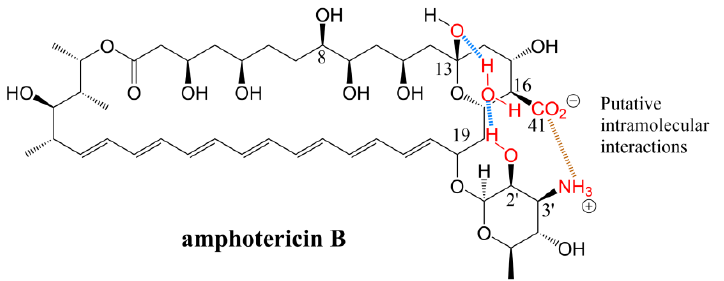
Figure 3. Intramolecular interactions of amphotericin B. The blue part represents the water bridge formed by water molecules between the hydroxy on C13 and the C2 ′ hydroxyl moiety on mycosa- mine, and the brown part represents the salt bridge formed by carboxylate on C16 and the C3 ′ position on the glycosyl [31].